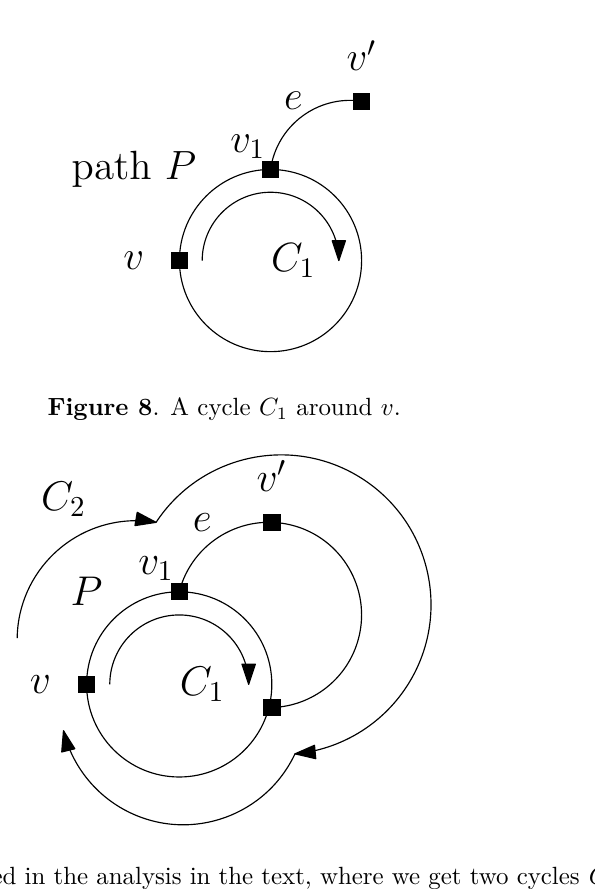
Figure 9 . The case described in the analysis in the text, where we get two cycles C 1 and C 2 with a common